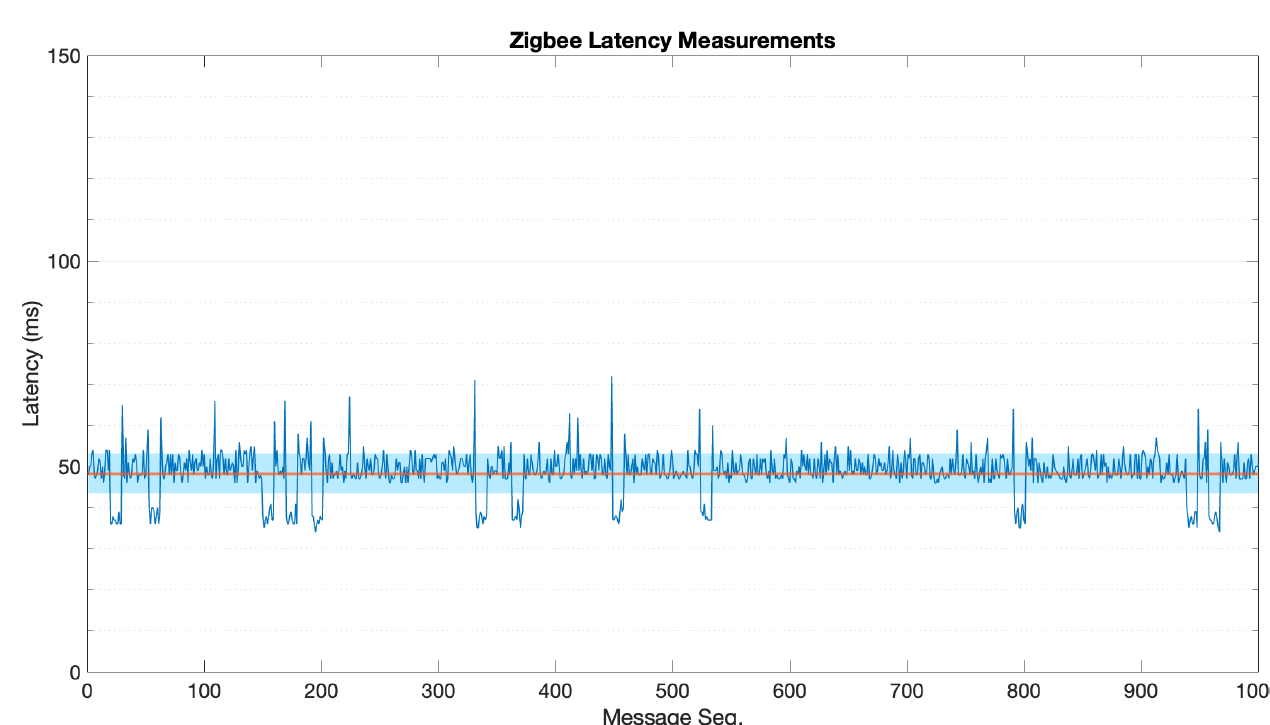
Figure A5. Latency plot for Zibgee.